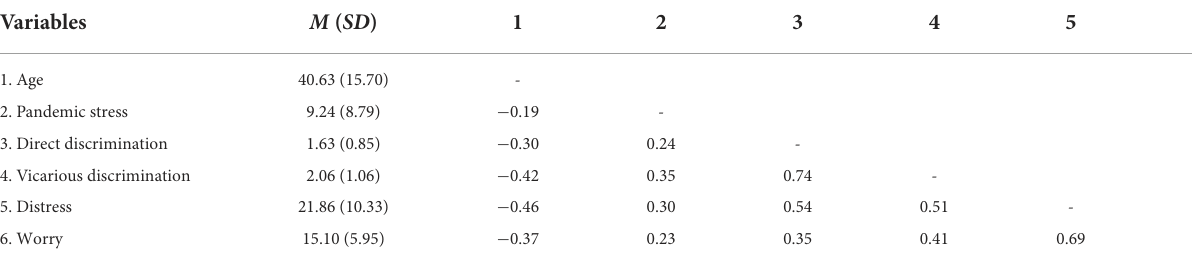
TABLE 3 Correlations among study